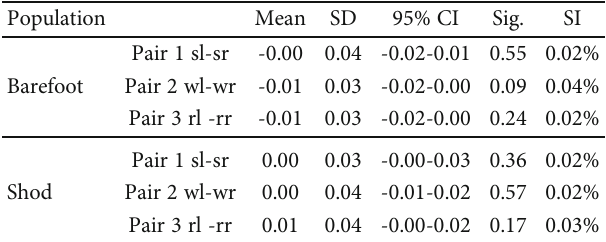
tant role during the movements. Arch compression/recoil, Table 2: Comparisons of arch index in left and right feet from